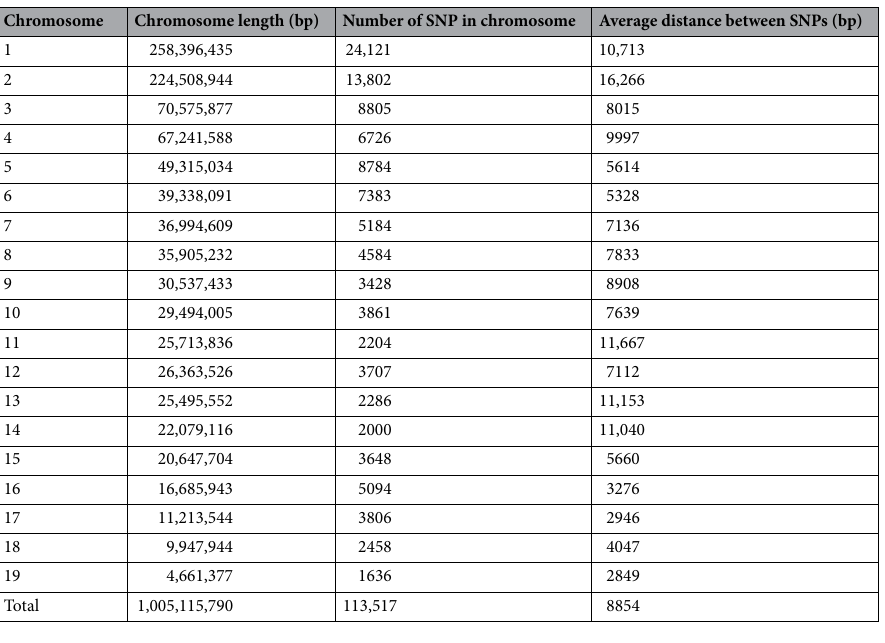
Table 1. Distribution and frequency of single nucleotide polymorphisms (SNPs) identified using the